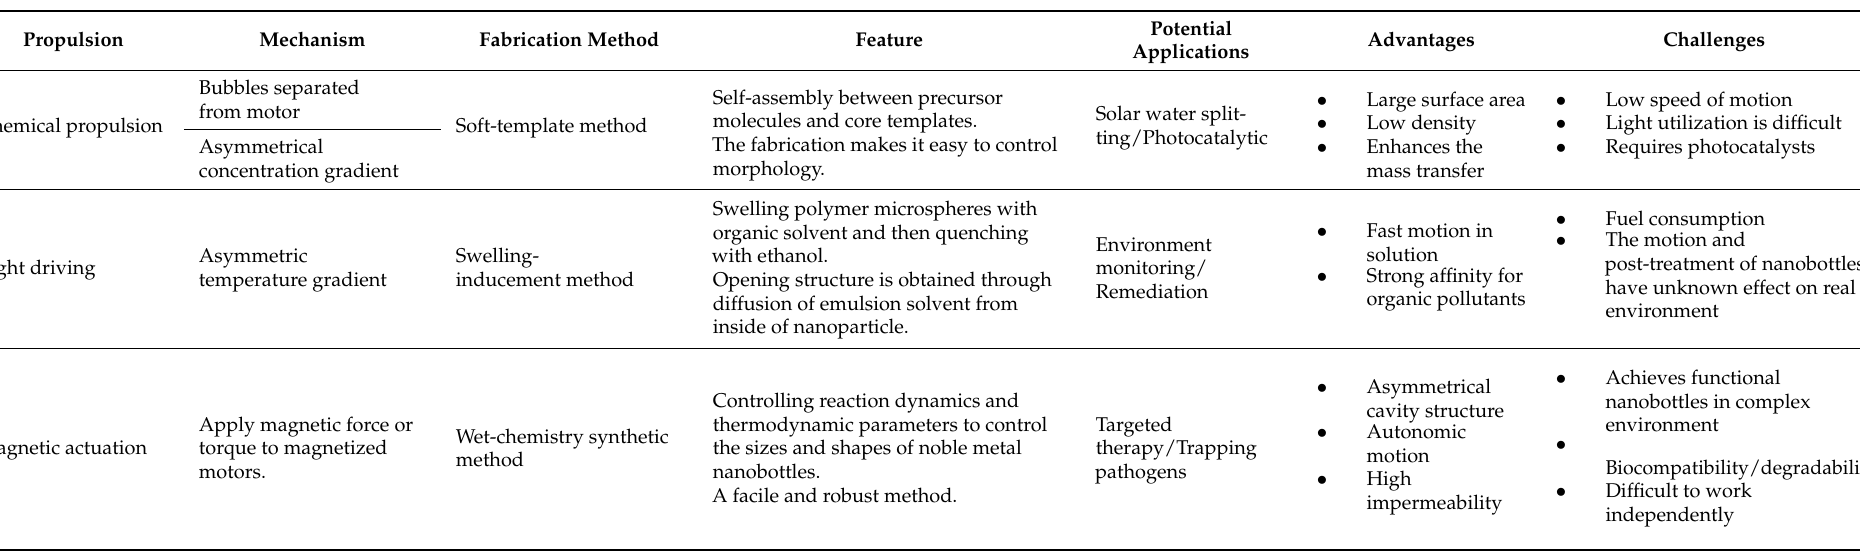
Table 3. The propulsion mechanisms, fabrication methods and potential applications of nanobottles as well as their major advantages and